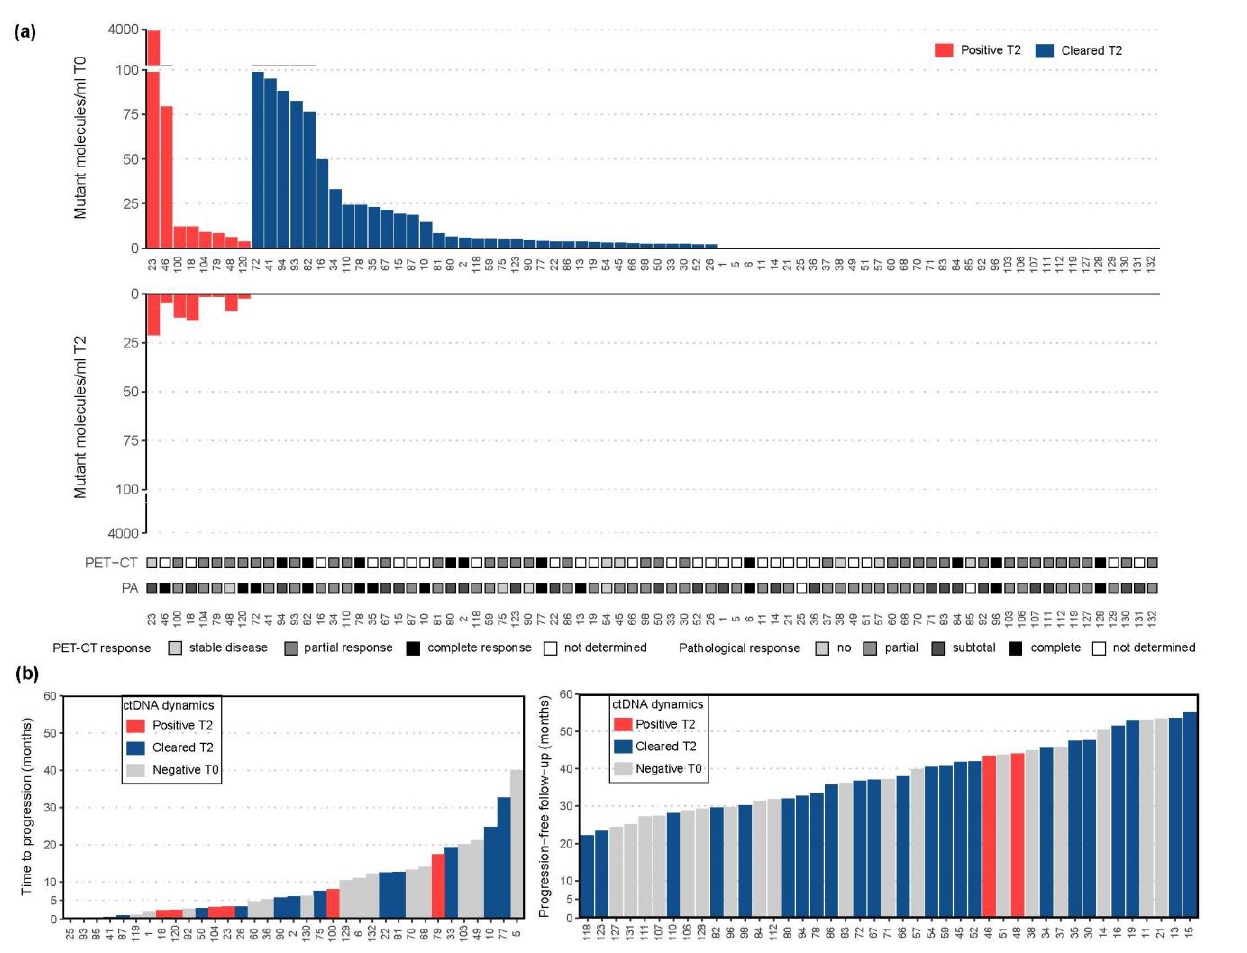
Figure 3. ctDNA dynamics and survival analysis: ( a ) ctDNA levels pre-CRT (T0) and preoperative (T2) combined with PET-CT response measurements and pathological response evaluation in grey. Patients are sorted according to ctDNA levels at T0 and presence of ctDNA at T2; ( b ) the time to progression (left panel) and progression-free follow-up (right panel); and ( c ) Kaplan – Meier analysis of progression-free survival and overall survival dividing patients according to ctDNA dynamics. Red ctDNA detected T0 and T2 (=positive T2); blue ctDNA detected T0, but not T2 (=cleared T2); grey ctDNA not detected T0 and T2 (=negative T0). Positron emission tomography – computed to- mography (PET-CT), circulating tumor DNA (ctDNA) .